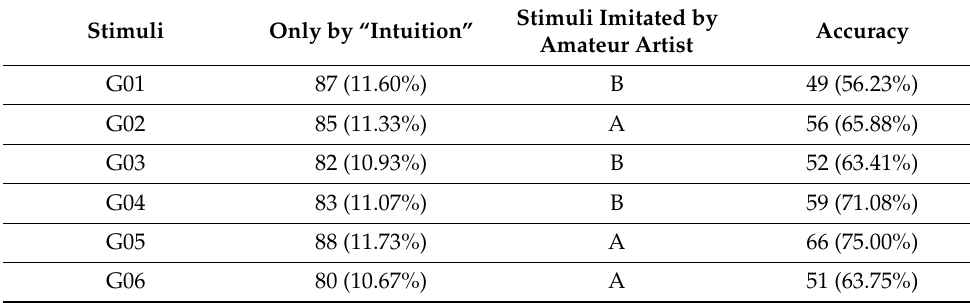
Table 8. Audiences used only “intuition” as the criterion for judgment.